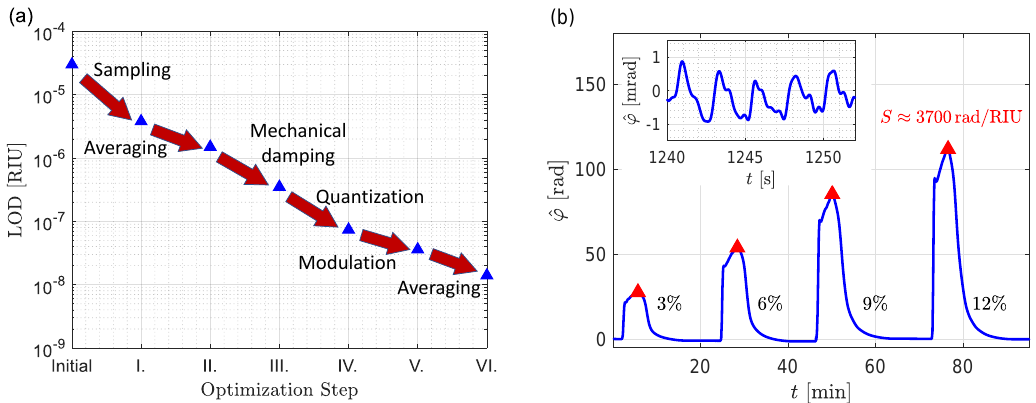
Figure 1. ( a ) Measured limit of detection of the integrated waveguide-based sensing system as different noise sources are addressed. ( b ) Sensor calibration with NaCl solutions shows a sensitivity of ≈ 3700 rad/RIU. The reduced noise shown in the inset is only achieved after dampening of mechanical noise and 2Hz low-pass filtering (0.5s averaging), i.e., steps I-III in Figure